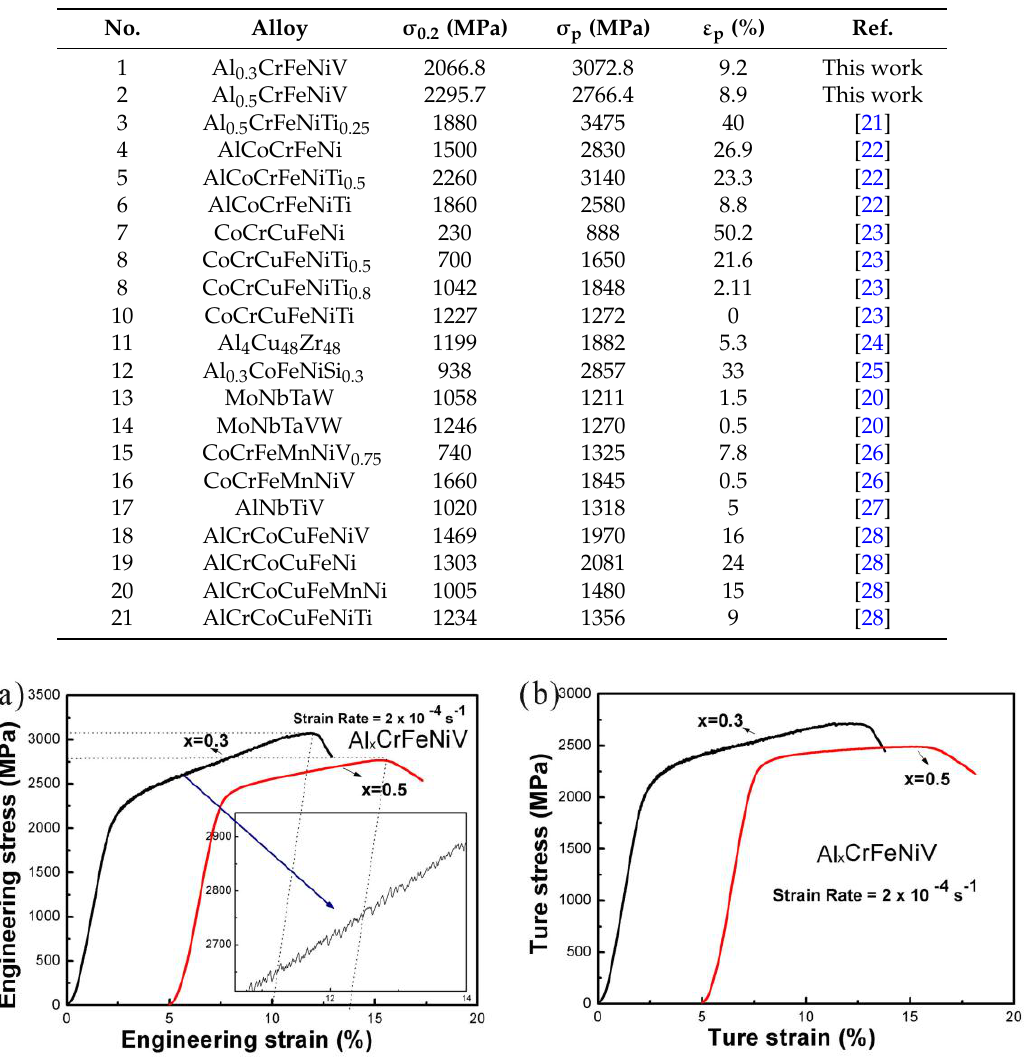
Figure 5. ( a ) Compressive engineering stress-strain curves; and ( b ) Compressive true stress-strain curves of the Al x CrFeNiV HEAs ( x = 0.3, and x = 0.5) cylindrical samples with 3 mm diameter × 6 mm height (with an aspect ratio of 2).